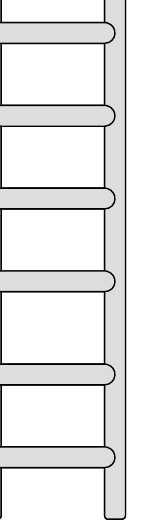
Figure 1: The customer ladder of loyalty Source: Adapted from Payne